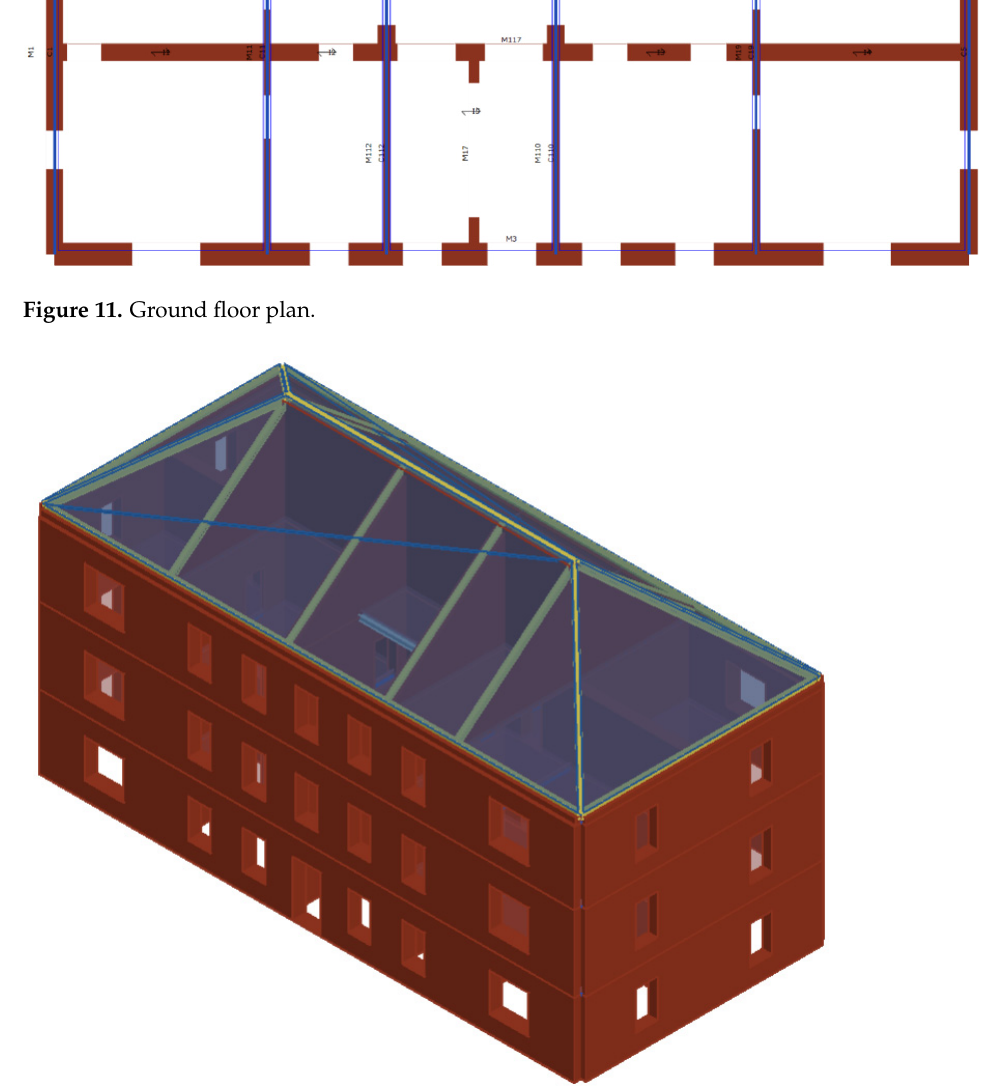
Figure 12. Three-dimensional (3D) model—view of the eastern façade. Table 2. Materials used in 3Muri model.